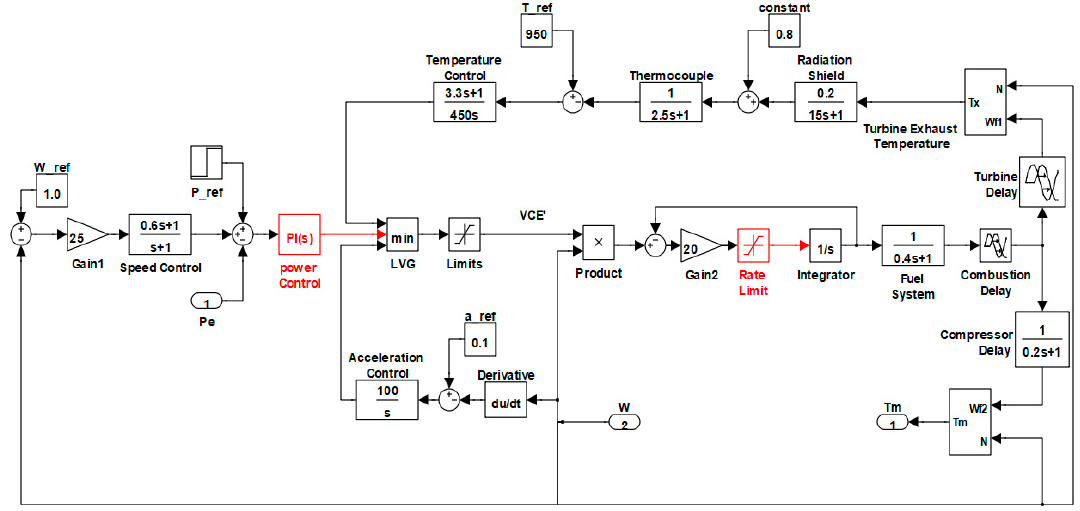
Figure 8. Simulation model of the micro gas turbine (MGT).